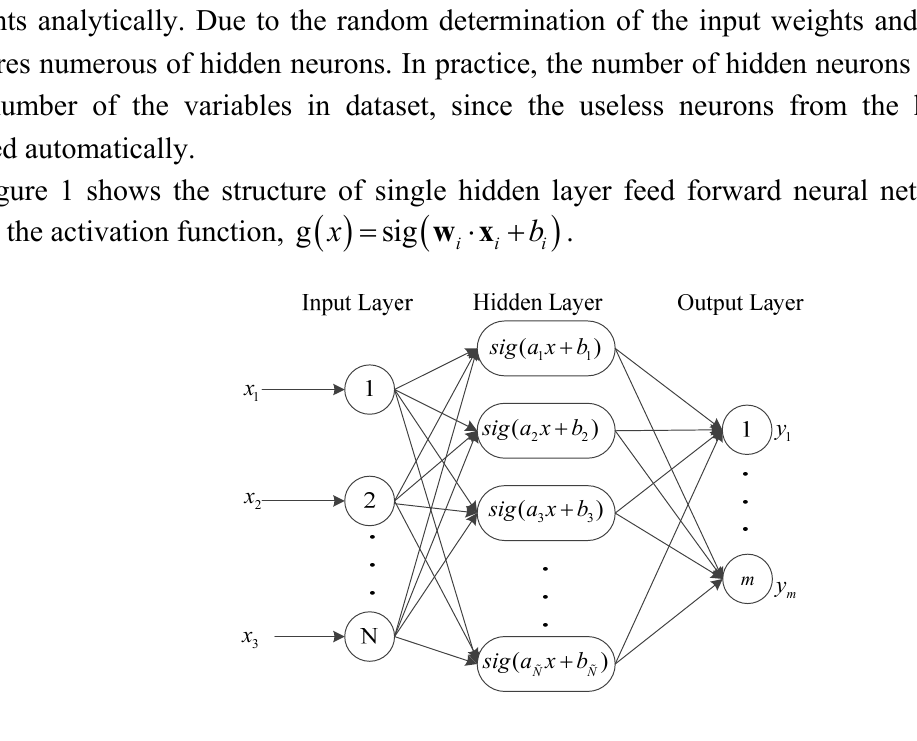
Figure 1. Structure of the single hidden layer feed forward neural network using Extreme Learning Machine